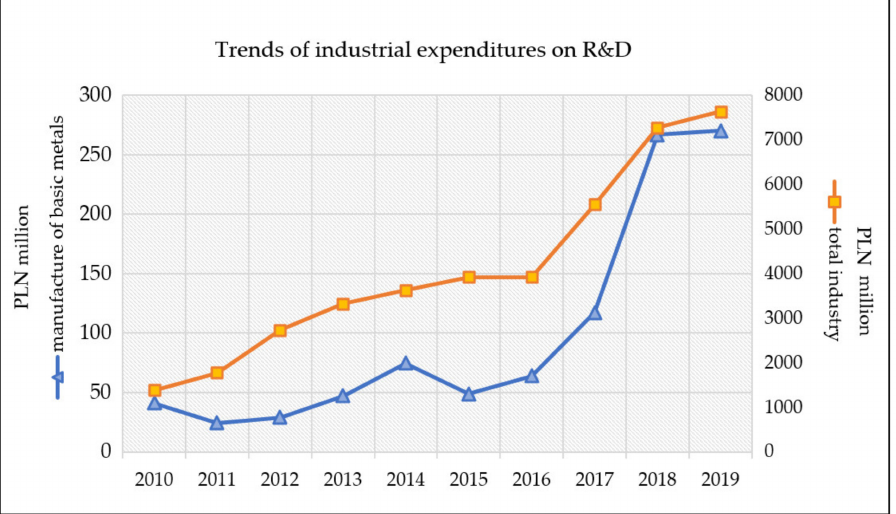
Figure 5. Comparison of expenditures on R&D for the manufacture of basic metals and total industry in Poland. Source: adapted with permission from Refs. [101–109].